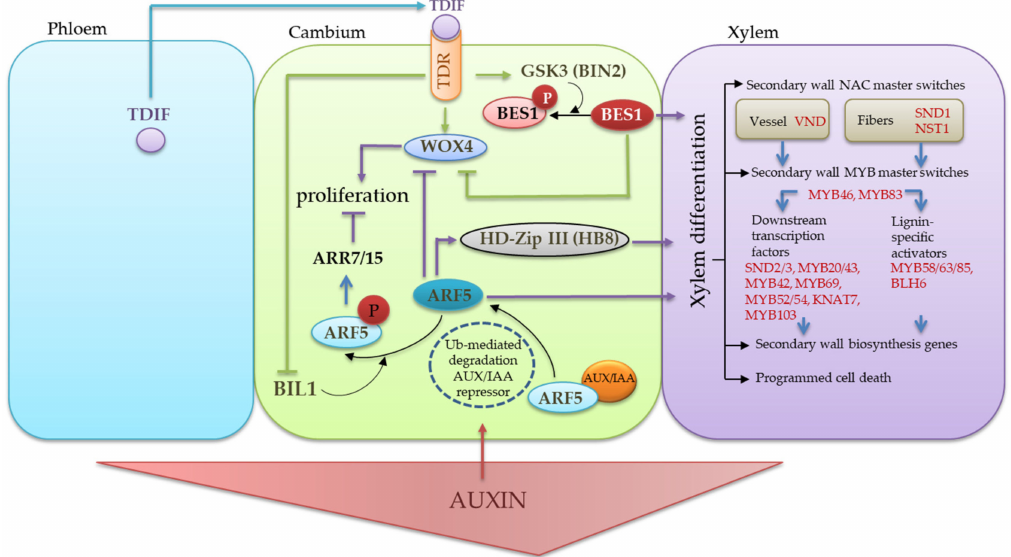
Figure 10. The schematic representation of the hormonal and molecular genetic regulation of cam- bium activity in woody plants. The TDIF signal peptide is produced in the phloem and migrates to the cambium, where it binds to its TDR receptor. The TDIF/TDR signaling activates WOX4 by regulating cambium cell proliferation [4,12,23]. TDIF binding to TDR activates GSK3 (BIN2) and leads to the phosphorylation and degradation of the BES1 protein. BES1 promotes xylem differentiation and also suppresses WOX4 expression, so its degradation preserves cambium pluripotency [37]. The TRD acts as a suppressor of another GSK3—BIN2-LIKE 1 (BIL1). BIL1 in the absence of TDR phosphorylates the auxin-dependent transcription factor of ARF5, releasing it by weakening the interaction of ARF5 with the AUX/IAA repressor [40]. Phosphorylation of ARF5 enhances its activity in suppressing the cytokine response through the expression of ARR7/15 and leads to a decrease in cambium proliferation [39]. Auxin signal transduction in cambial stem cells is required to maintain cambial activity [20]. The level of auxin signal transmission increases in the differentiating xylem. High concentrations of auxin promote the ubiquitin-mediated proteolysis of Aux/IAA transcriptional repressors, releasing ARF5 to regulate xylem differentiation. ARF5 autonomously limits the number of stem cells by downregulating the WOX4 activity and increasing the HB8 gene expression, positively influencing xylem differentiation